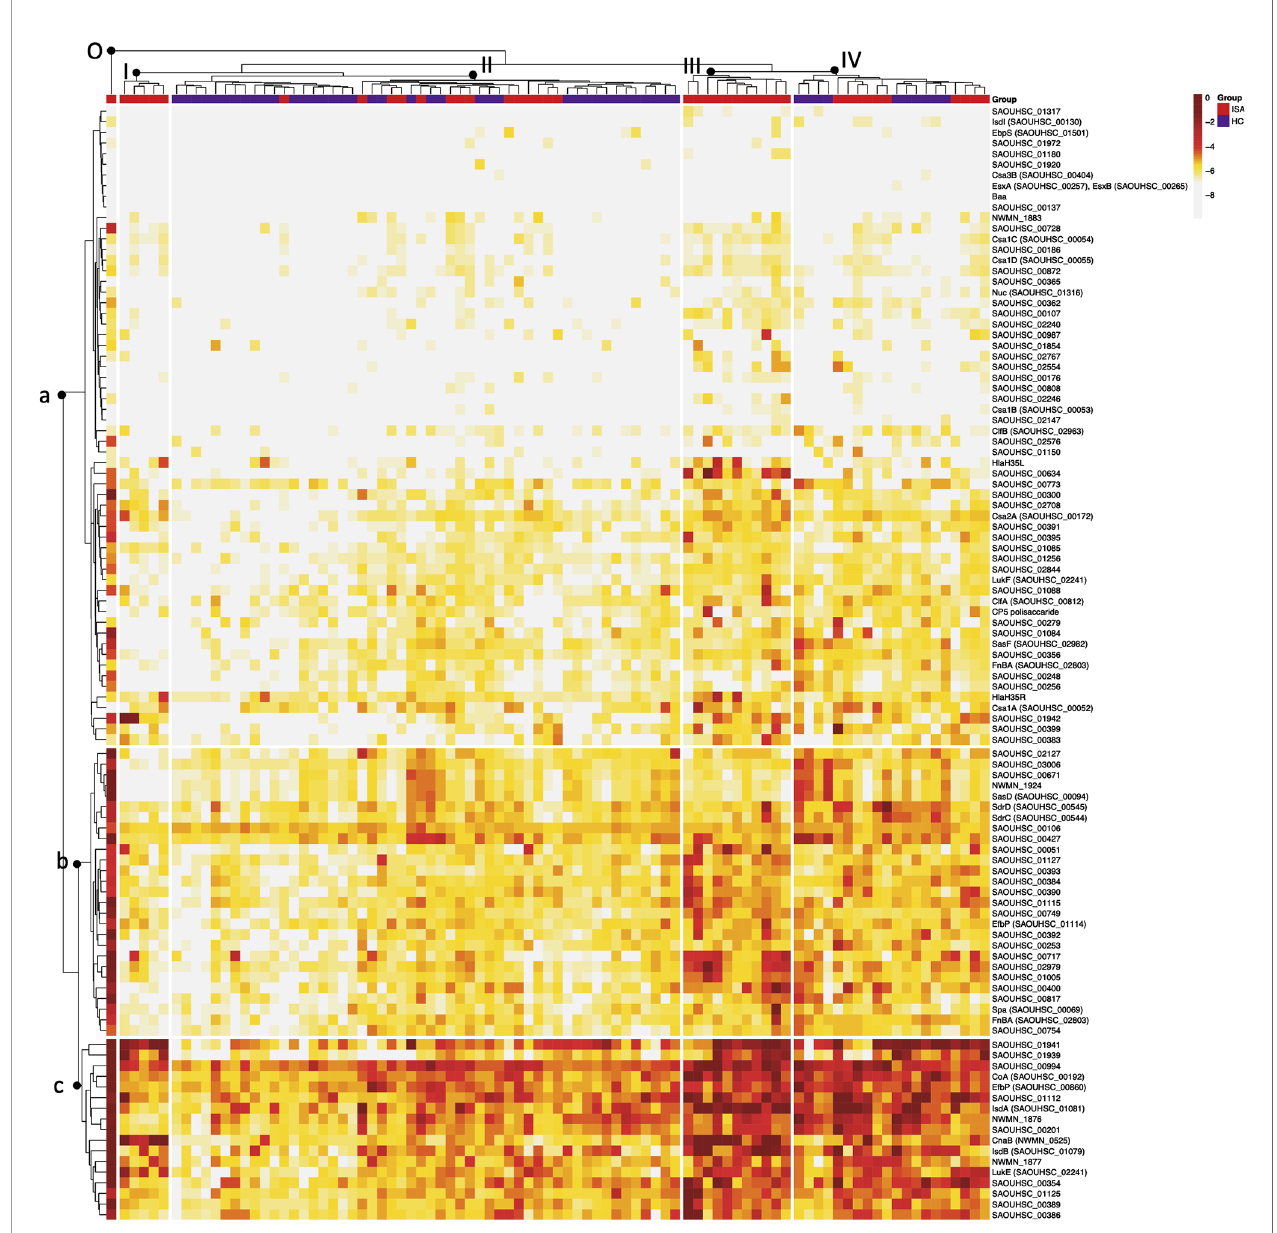
FIGURE 3 | Heatmap and bidimensional cluster analysis of all normalized data based on Euclidean distance. Cluster analysis of the Mean Fluorescence Intensity (MFI) data obtained from all S. aureus antigens tested (rows) against single sera sample (columns). Darker to lighter tones indicate the concentrations of each sample and protein as indicated in the scale bar. The fi ve major clusters identi fi ed in the sera are indicated on top of the dendrogram (I-II-III-IV; O: outlier cluster). For each subject are reported in the clustering the corresponding group, depicted in red (12) and in blue (HC). The three major clusters are indicated with a dendrogram on the left-hand side of the graph (a = low, b = medium, c =